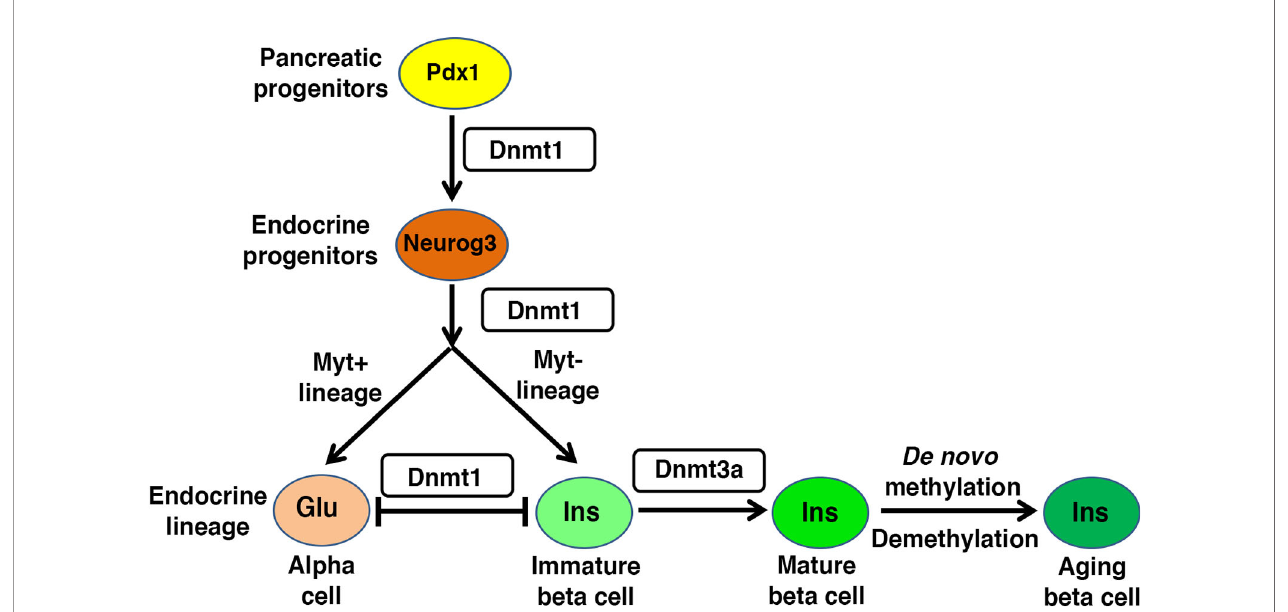
FIGURE 2 | Regulatory role of DNA methylation in beta cell homeostasis: Pancreas morphogenesis requires intact maintenance methylation activity of Dnmt1 in Pdx1+ pancreatic progenitors, and loss of Dnmt1 in pancreatic progenitors leads to pancreatic atrophy. Speci fi cation of different endocrine lineages from the Neurog3+ endocrine progenitors involves the DNA methylation dependent regulation of the expression of lineage-speci fi c transcription factors. The endocrine progenitors that co-express Myt1, are marked by high expression of Dnmt1 and hypermethylation of the enhancer region of Arx , a key alpha cell lineage determinant. This leads to repression of Arx and commitment of the Neurog3+ Myt1+ sub-population to beta cell lineage, while the Neurog3+ Myt1- sub-population acquires alpha cell lineage. Functional maturation of beta cells is neonatal life depends on DNA methylation patterning of genes involved in metabolism and replication. The fully differentiated beta cell phenotype is guarded by maintenance methylation through replication, and loss of Dnmt1 in beta cells leads to their trans-differentiation into alpha cells. The proliferative capacity and function of beta cell changes with age, and involves age dependent changes in the beta cell